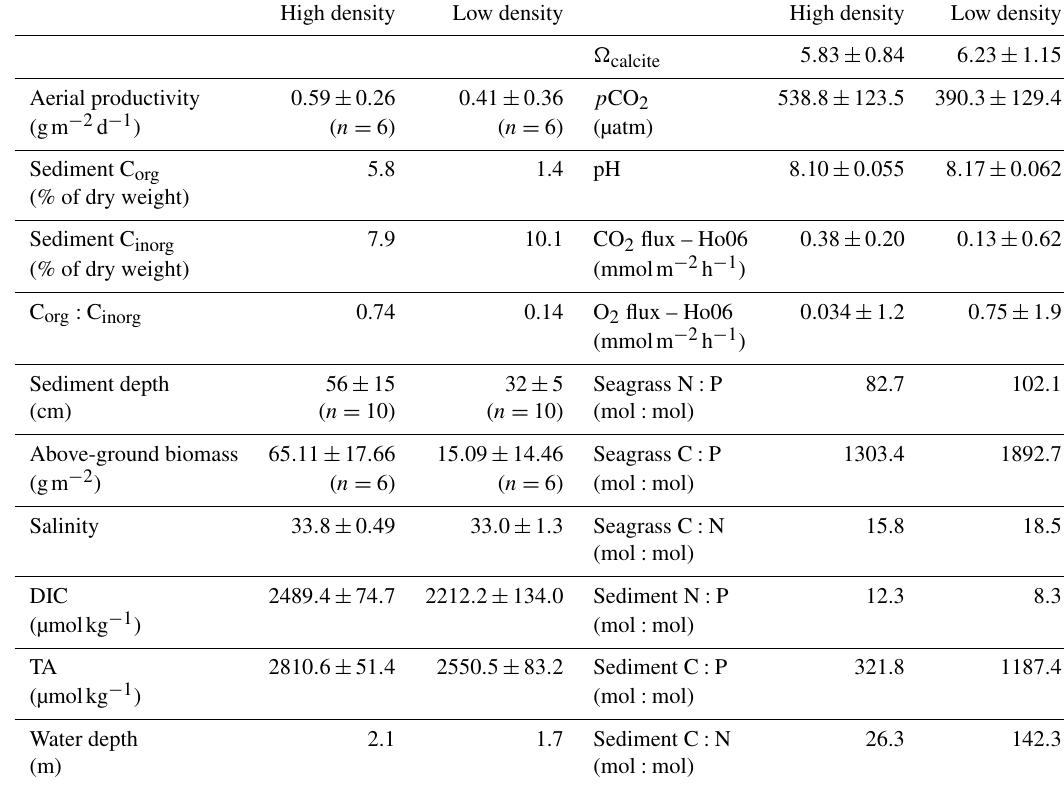
Table 1. Table of physicochemical conditions (TA, DIC, and salinity) and seagrass and sediment chemical characteristics (average ± SD). High density Low density High density Low